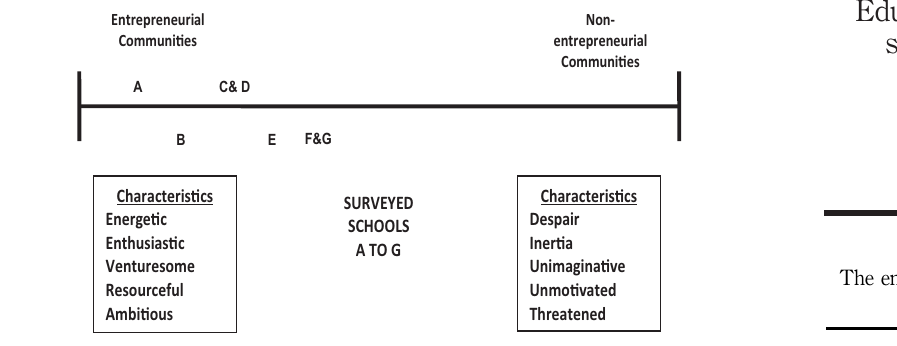
Figure 1. The entrepreneurial